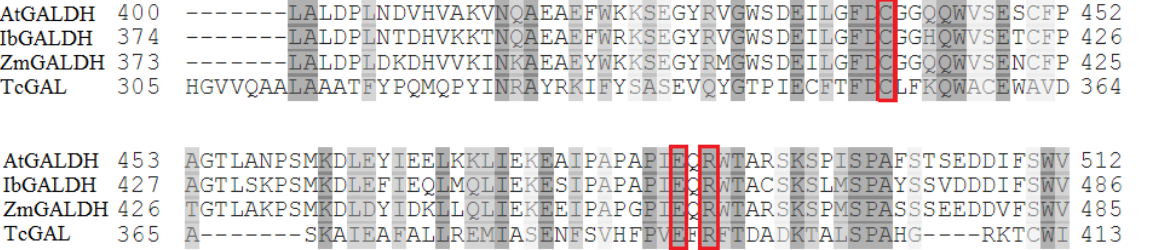
Figure 4. Clustal Omega multiple sequence alignment of AtGALDH, TcGAL and two L -galactone-1,4-lactone dehydrogenases from Ipomoea batatas (IbGALDH) and Zea mays (ZmGALDH). The accession numbers used are as follows: AtGALDH, Q9SU56; IbGALDH, Q9ZWJ1; ZmGALDH, A0A3L6FX76; TcGAL, A0A2V2VEI5.